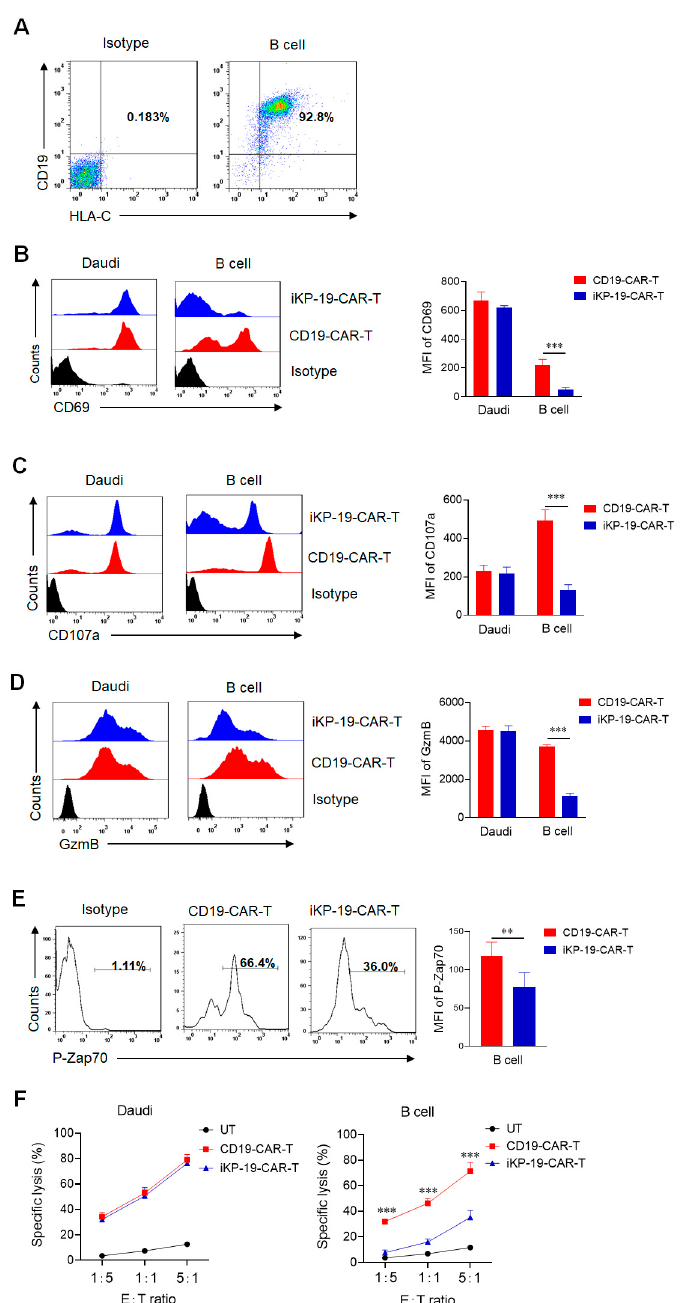
Figure 4. In vitro cytotoxicity of iKP-19-CAR-T cells against CD19 + HLA-C1 − Daudi cells or CD19 + HLA-C1 + normal B cells. ( A ) Representative CD19 and HLA-C1 expression in B cells. ( B – E ) After CD19 CAR rate was unified, iKP-19-CAR-T cells and CD19-CAR-T cells were co-cultured with Daudi cells or normal B cells at a 1:1 ratio for 6 h in RPMI-1640 medium. The expressions of activation marker CD69 ( B ), degranulation marker CD107a ( C ), GzmB ( D ), and signal molecule P-Zap70 ( E ) in CAR-T cells was detected by flow cytometry using PE-anti-human CD69 antibody, PE-anti-human CD107a antibody, PE-anti-human GzmB antibody and PE-anti-human P-Zap-70 antibody. MFI was statistically measured from three independent experiments ( n = 4 different donors). ( F ) LDH assay was performed to test the cytotoxicity of iKP-19-CAR-T cells and CD19-CAR-T cells against Daudi cells or normal B cells after 6h co-culture at different E:T ratio ( n = 4 different donors). All experiments were performed in triplicate manner using PBMCs of every donor. ** p < 0.01, *** p < 0.001. Error bars represent ± SD.